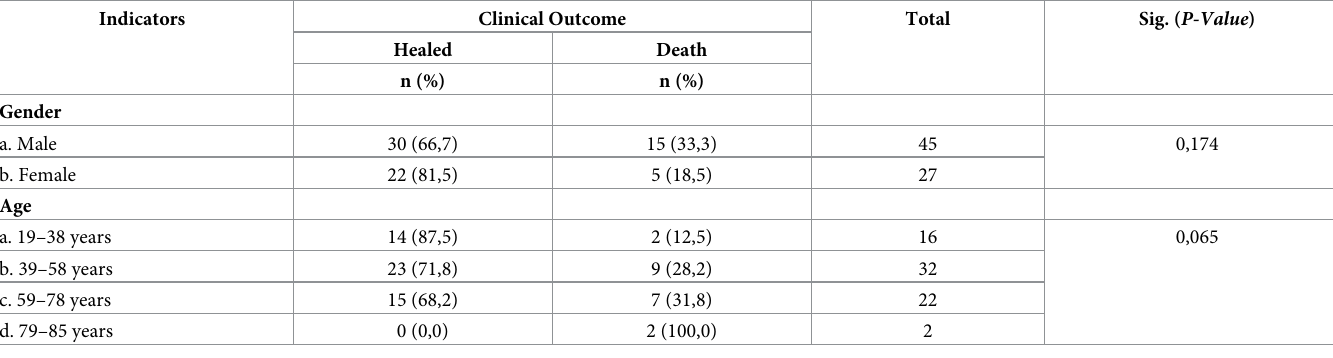
Table 2. Correlation between socio-demography and clinical outcome.